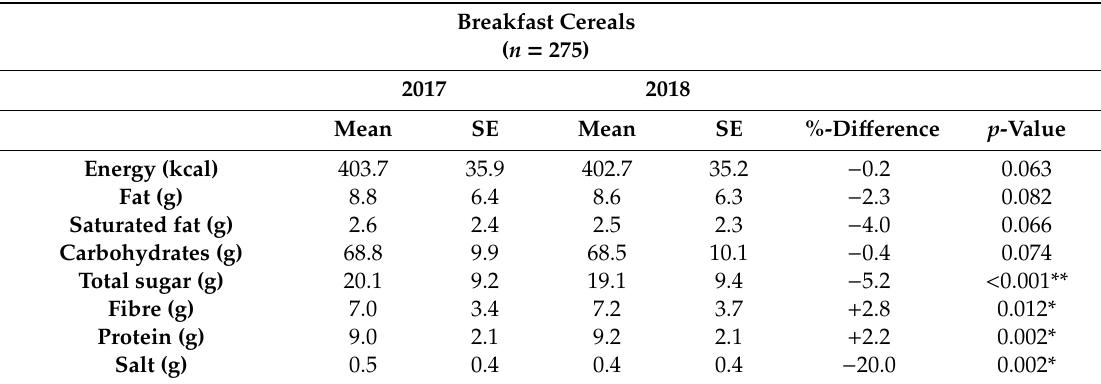
Table 3. Nutritional content per 100g in 2017 and 2018 for corresponding breakfast cereals (Mean + SE) . Breakfast Cereals